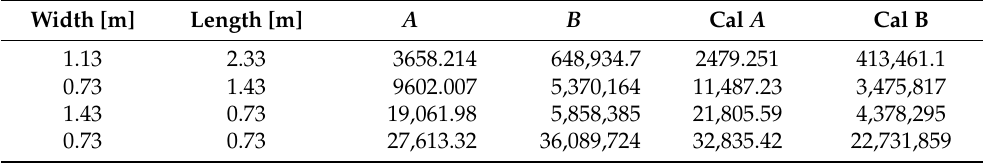
Table A8. The 10 mm plate faculty lab vacuum tests A , B and theory calculated A , B .